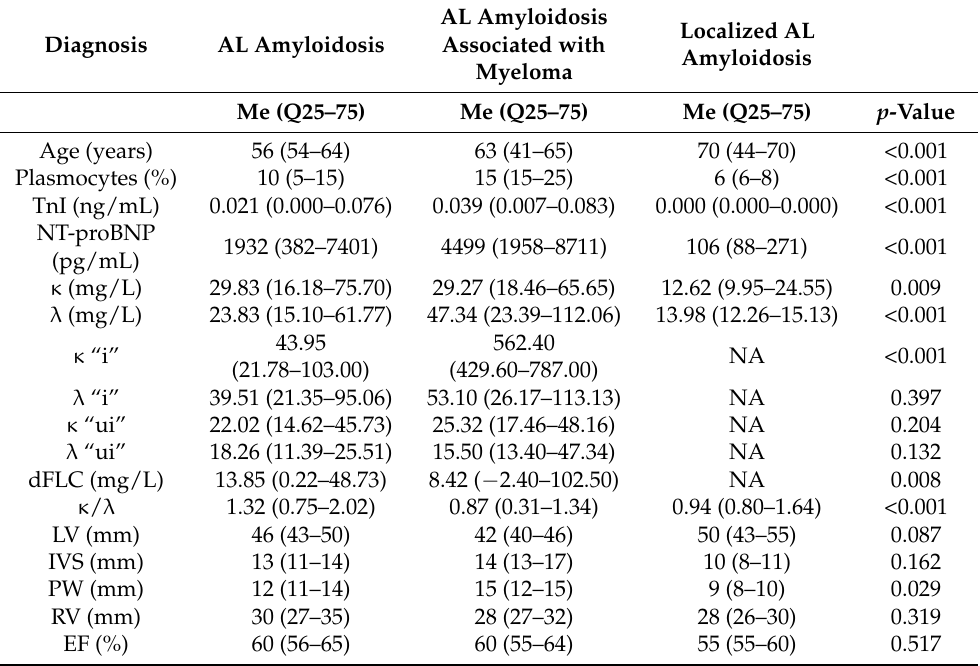
Table 7. Comparative analysis depending on the diagnosis.